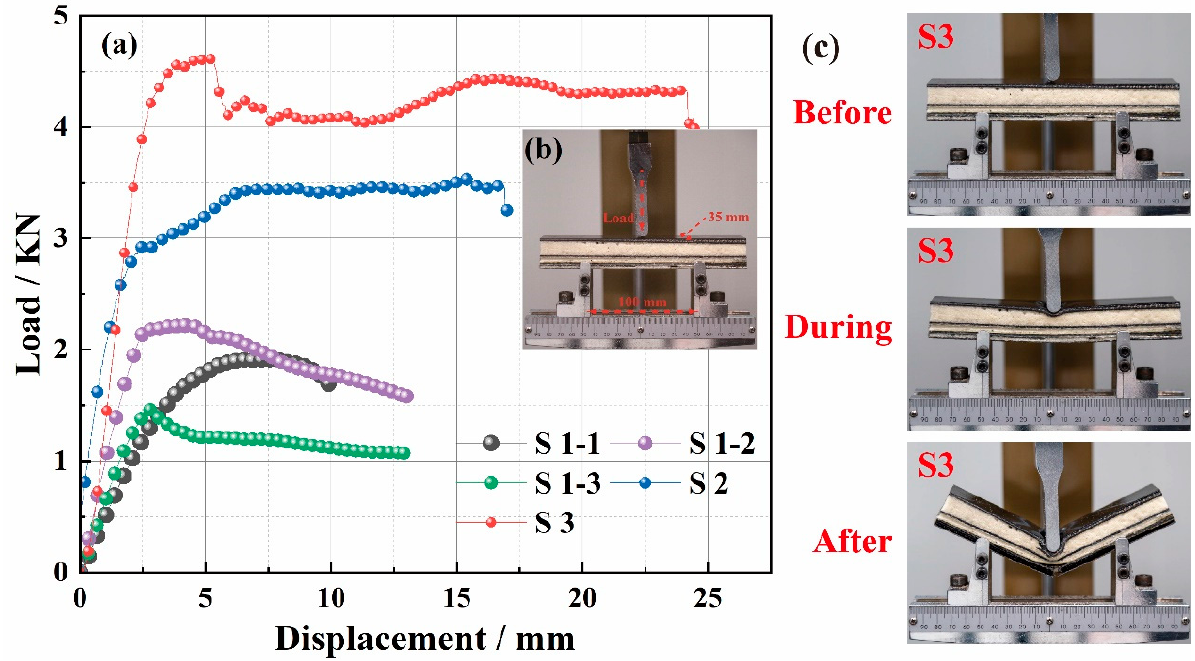
Figure 8. The bending behaviors of the 3D GHWC with triangular sections. ( a ) Bending load–displacement curve; ( b ) experiment settings; ( c ) comparing images of before, during, and after bending.